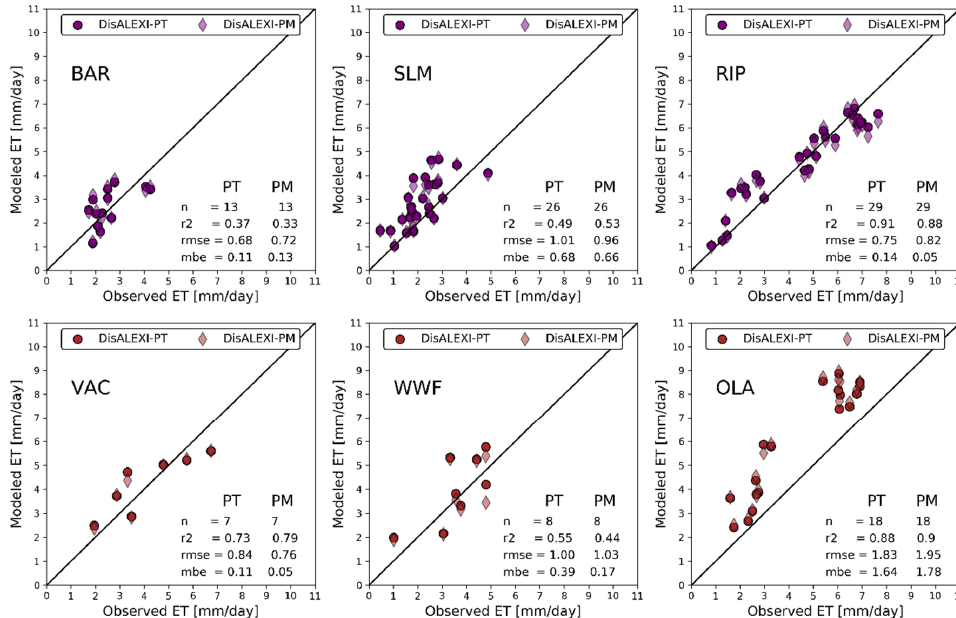
Figure 3. Scatter plots of DisALEXI-PT- and DisALEXI-PM-derived daily ET vs. observed daily ET (unclosed) for GRAPEX vineyards ( top ) and T-REX almond orchards ( bottom ) on clear Landsat 8 overpass dates during 2021. Additionally, included are statistical measures n (number of clear-sky images available), r2 (coefficient of determination), rmse (Root Mean Square Error), and mbe (Mean Bias Error). Differences between the number of comparison points (n) and the number of clear-sky days (Table 1) are due to missing observed data during the Landsat overpass.